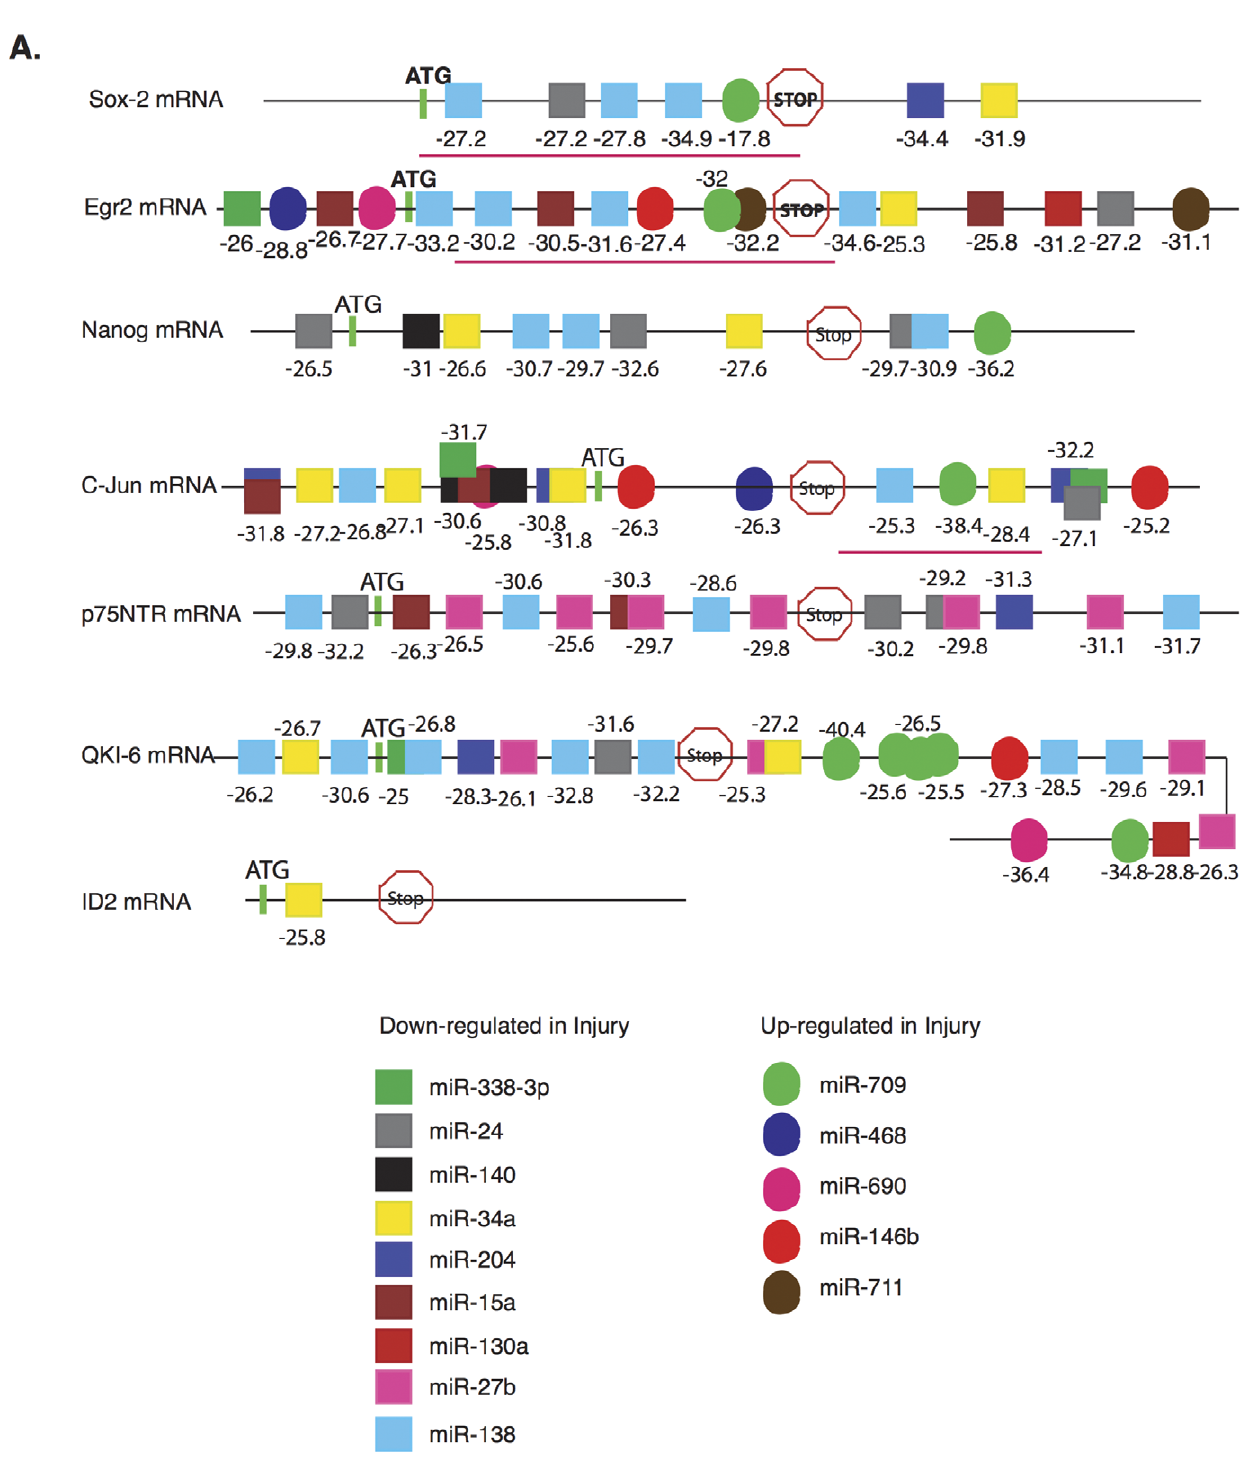
Figure 2. miRNA-mRNA target prediction and evaluation. Putative miRNA binding sites detected by RNA 22 are represented on individual mRNAs (not to scale) as squares (repressed in injury) or circles (up regulated in injury) with the maximum folding energy shown below. Underlined areas indicate regions used in Luciferase assays.